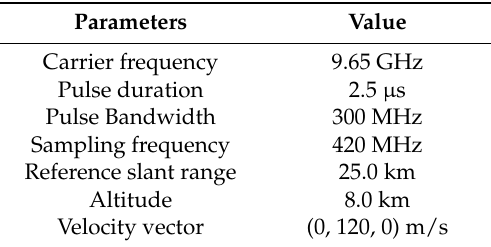
Table 1. Parameter